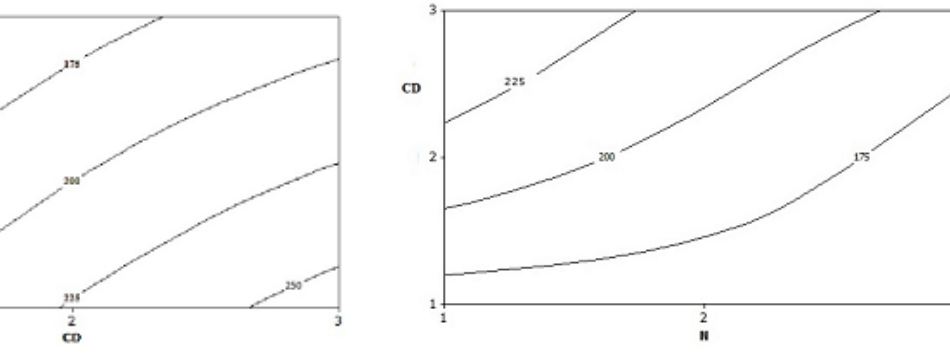
Fig. 5. Contour diagram of average water droplet size in terms of the concentration of demulsifier and mixing speed.